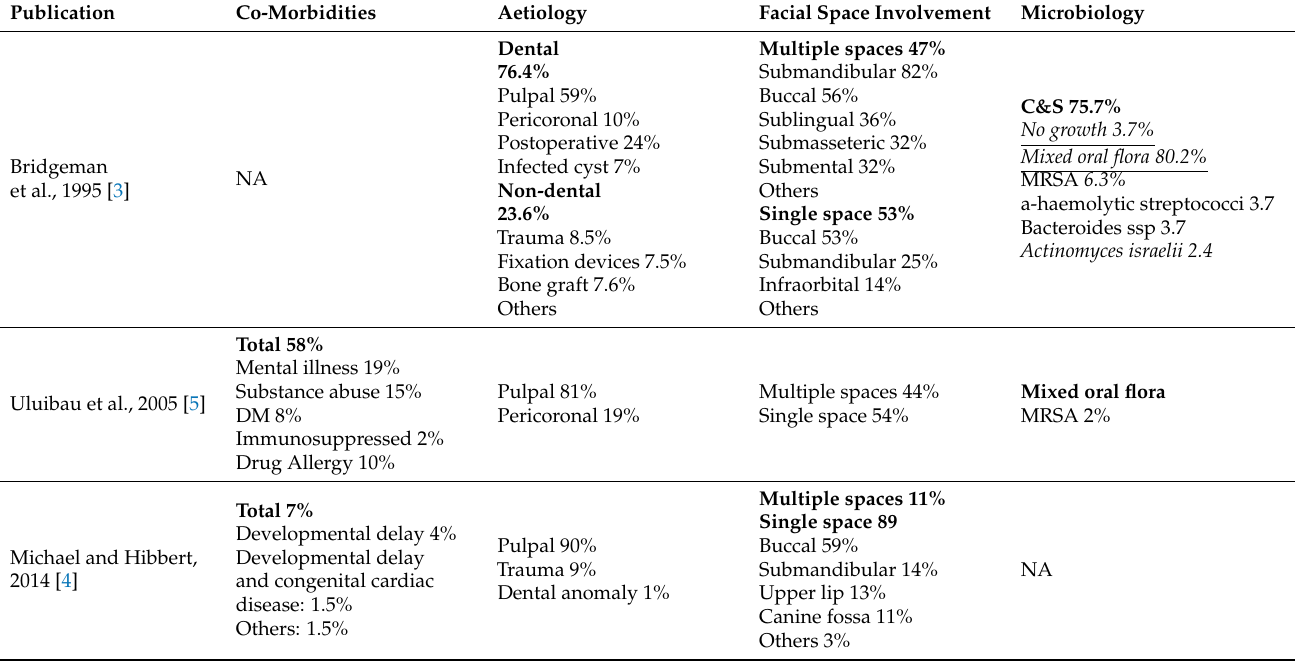
Table 2. Demographics, aetiology, features and microbiology of dental